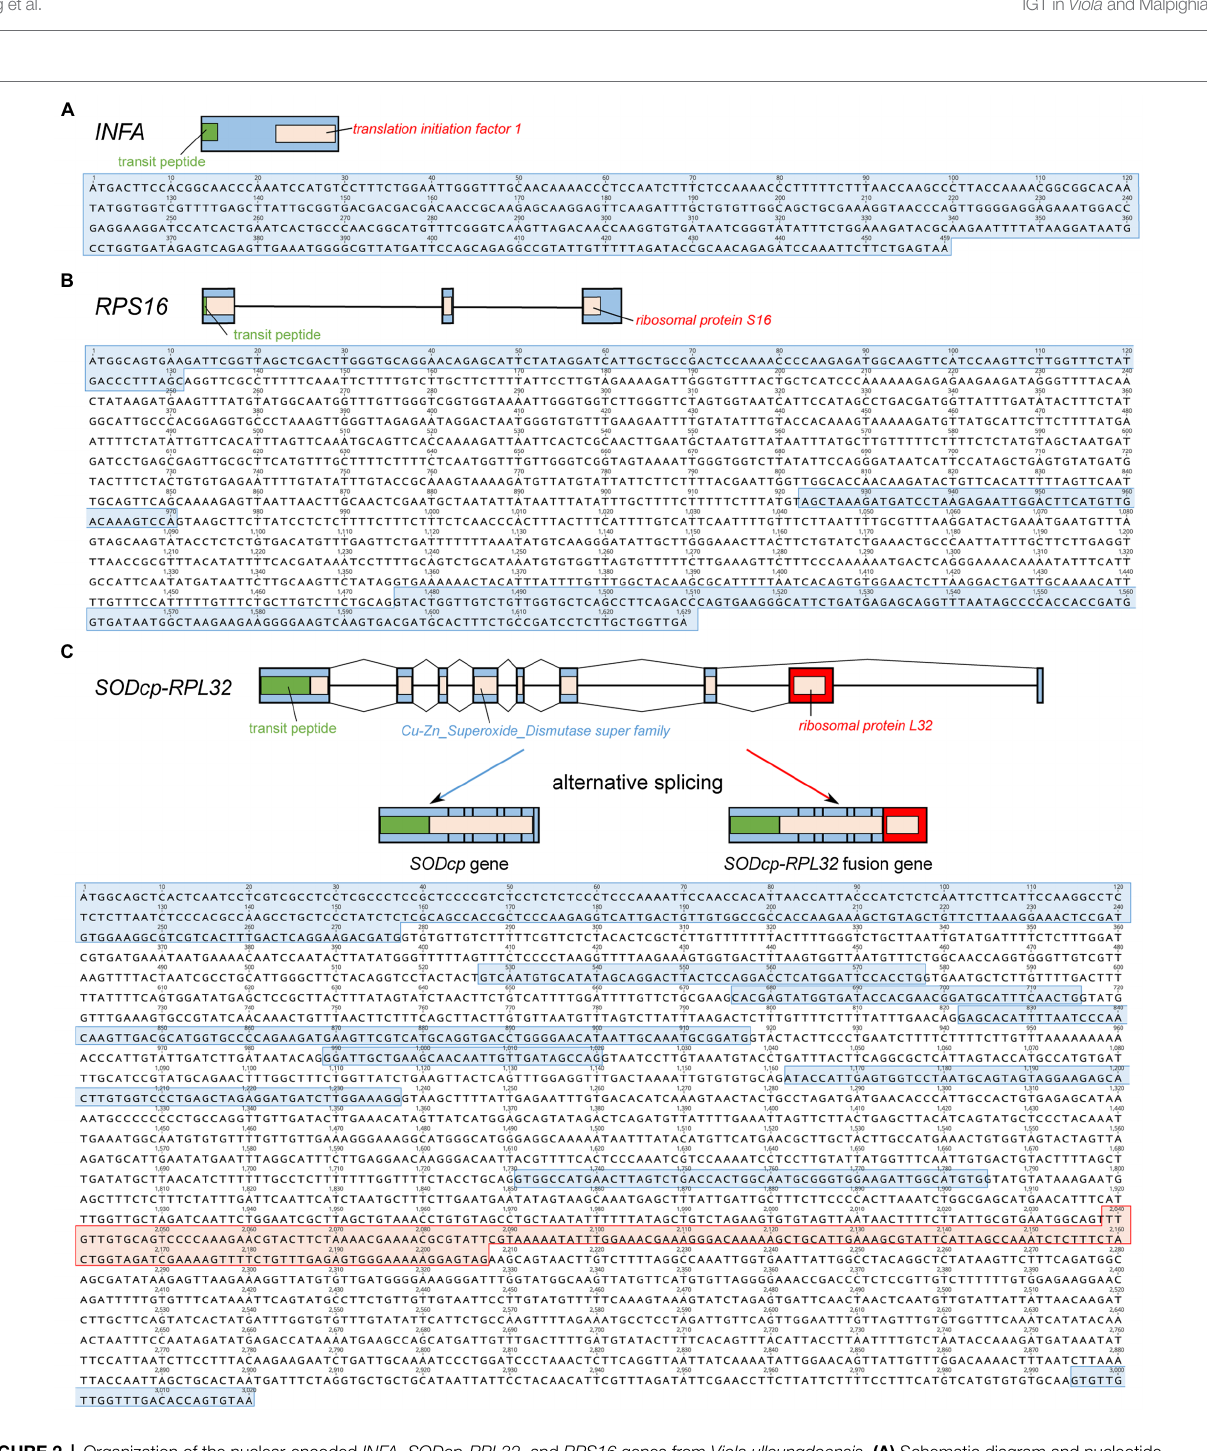
FIGURE 2 | Organization of the nuclear-encoded INFA , SODcp-RPL32 , and RPS16 genes from Viola ulleungdoensis . (A) Schematic diagram and nucleotide sequence of the nuclear-encoded INFA gene. (B) Schematic diagram and nucleotide sequence of the nuclear-encoded RPS16. (C) Schematic diagram and nucleotide sequence of nuclear-encoded SODcp-RPL32 as a chimeric gene with alternative splicing. Blue and red boxes denote exons and RPL32 gene regions, respectively. Green boxes indicate transit